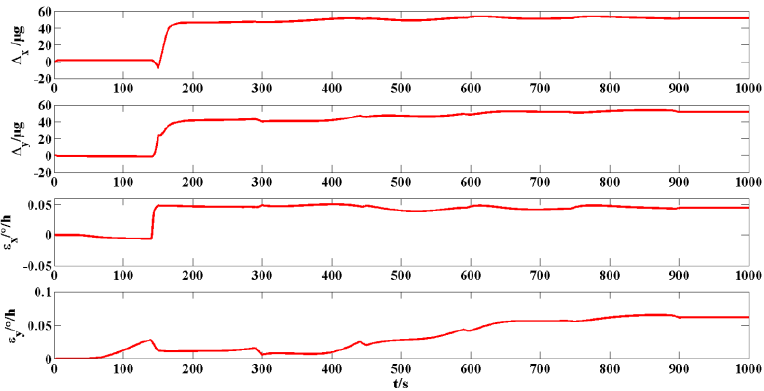
Figure 8. Estimation values of IMU constant error (circular maneuver).